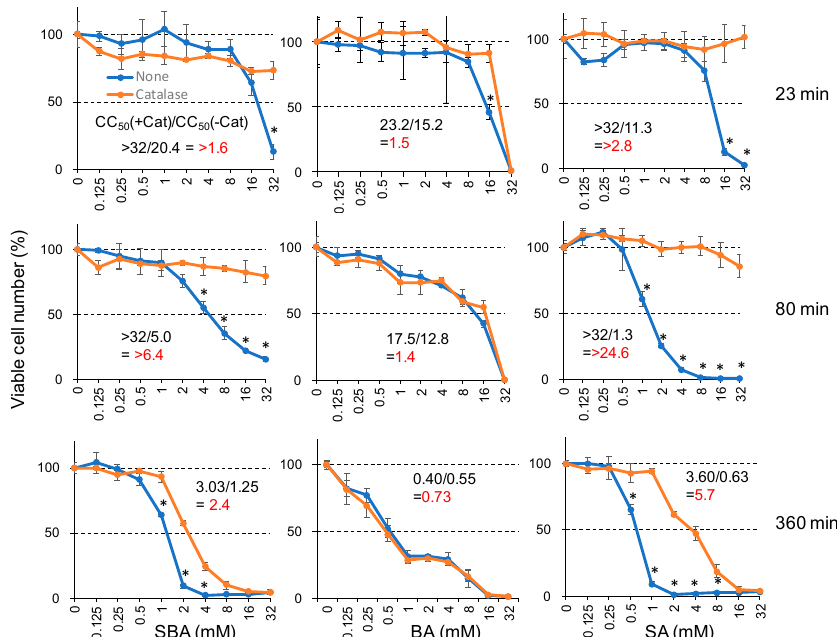
Figure 2. Involvement of extracellularly released hydrogen peroxide in the cytotoxicity induced by SA and SBA, but not BA. HSC-2 cells were incubated for 23, 80, or 360 min with the indicated concentrations of each compound in the presence or absence of catalase (3000 units/mL), and then replaced with fresh medium and incubated for a total of 48 h. Viable cell number was determined by MTT method, and expressed as % of control (drug-free, catalase-free). Each value represents mean ± S.D. of triplicate assays. * Significant difference from control p < 0.05.